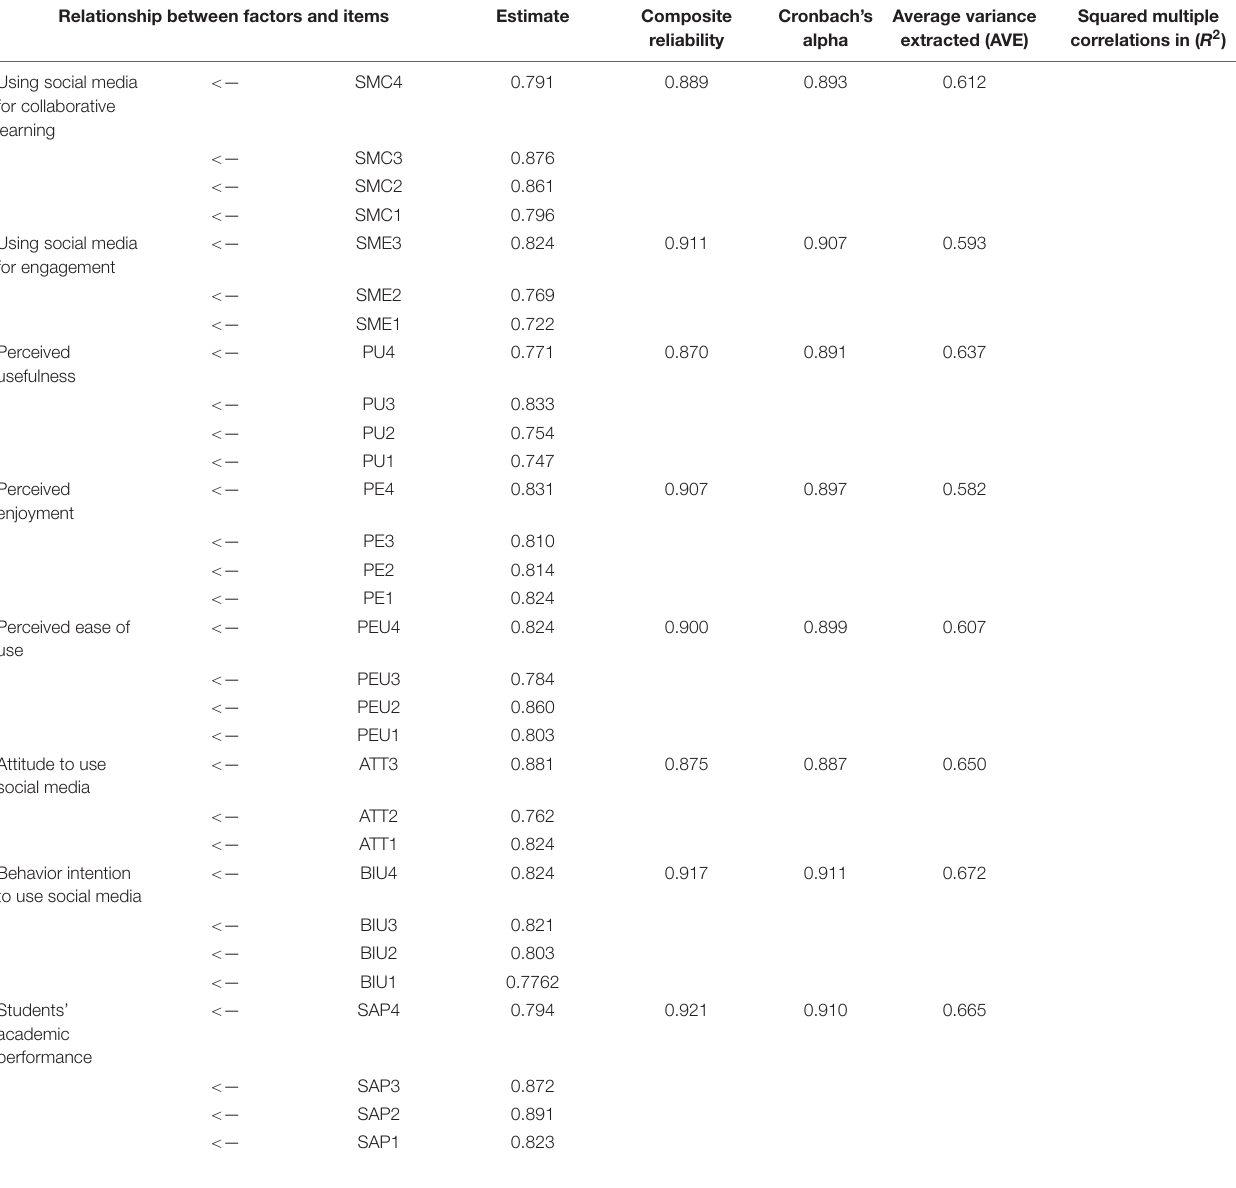
TABLE 1 | Relationship between factors and items (Validity and Reliability).